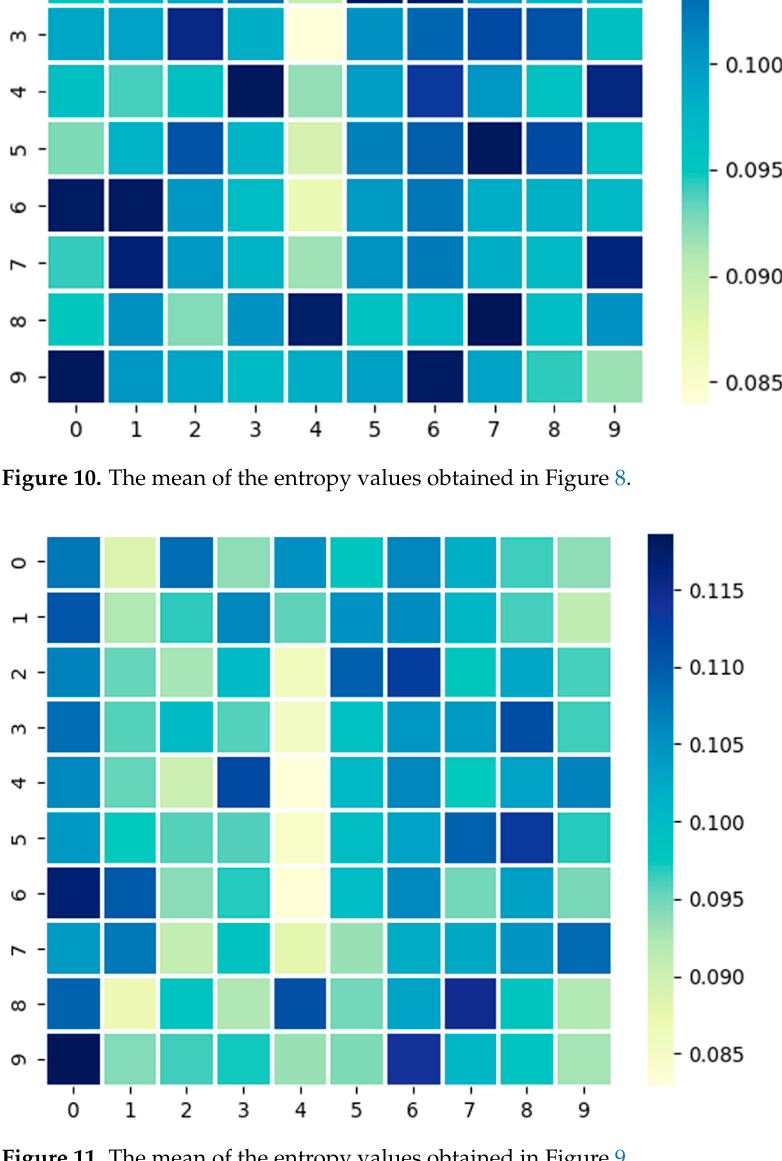
Figure 11. The mean of the entropy values obtained in Figure 9.